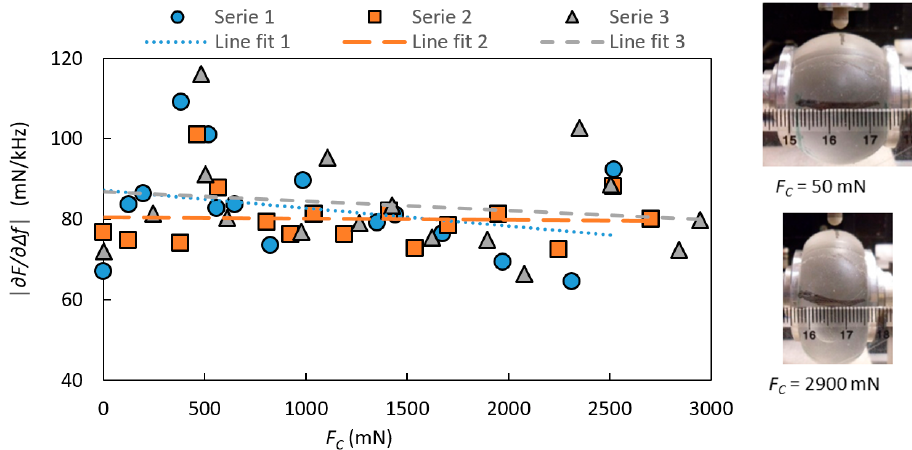
Figure 5. The stiffness parameter | ∂ F / ∂ ∆ f | with the indentation depth I = 0.6 mm, measured on a homogeneous silicone sphere as a function of the clamping force, F C . The measurements were made at an angle of sensor movement α sm = 0 ◦ . To the right, two pictures illustrate the visible effect of F C on the silicone sphere.